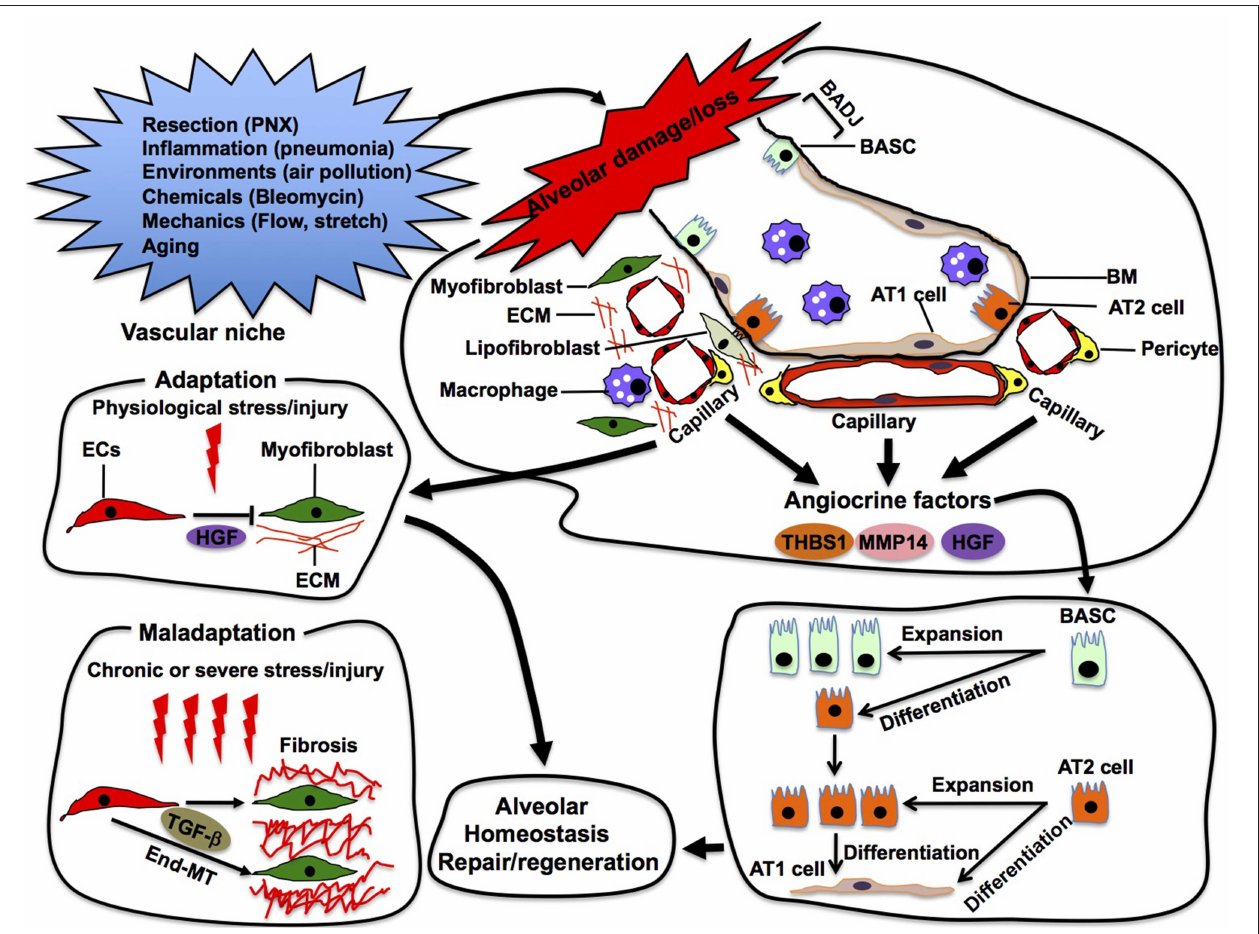
FIGURE 5 | Alveolar repair in the vascular niche. Capillary ECs sense damage or loss of alveoli and produce angiocrine factors (e.g., thrombospondin 1 (THBS1), MMP14, HGF) in the vascular niche. These angiocrine factors enhance repair and/or regeneration of the damaged alveoli by stimulating propagation and/or differentiation of epithelial stem cells (e.g., AT2, BASC) in the alveoli. In the niche, ECs also adapt to physiological stress/injury to maintain tissue homeostasis. Under severe or chronic stress/injury, maladapted ECs provoke myofibroblasts, leading to pathological conditions such as fibrosis. Maladapted ECs also transdifferentiate into myofibroblasts (End-MT) to accelerate